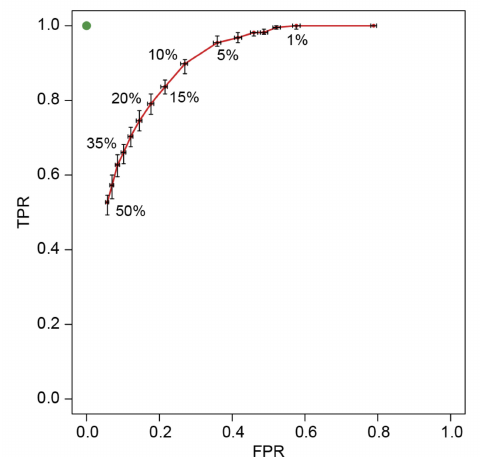
Figure 8. Classification of thresholds at di ff erent non-exceeding probabilities (black points) in the ROC space. The threshold closest to the best prediction point (green point) is the optimal threshold. Horizontal and vertical bars represent the range of variation of TPR and FPR for the 100 runs in which the MPRCs are randomly